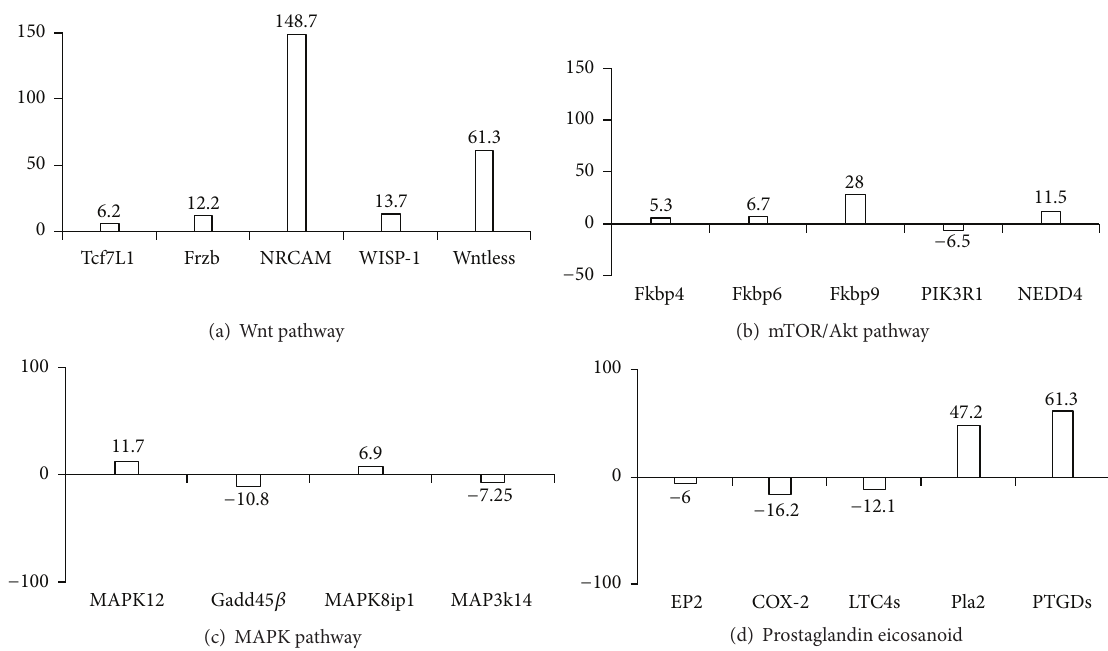
Figure 4: Expression level of molecules involved in signal transduction of the Wnt pathway (a), the mTOR/Akt pathway (b), the MAPK pathway (c), or prostaglandin, eicosanoid pathway (d). Microarray data for DC-tumor cell hybrids and DCs were compared. Positive values indicate upregulation in DC-tumor cell hybrids. Data from different probe sets were obtained for Frzb, WISP-1, and Gadd45 𝛽 . For these gene products the average in gene expression is